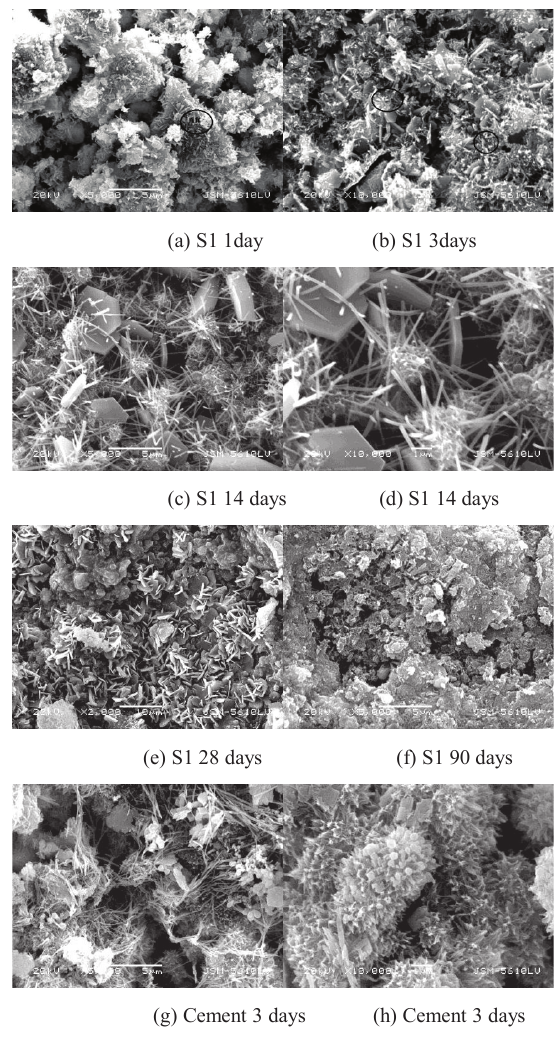
Figure 7: SEM analysis of paste hydration products (a-f: SEM of S1 paste curing at 1, 3, 14, 28, 90 days; g-h:SEM of cement paste curing at 3 days).